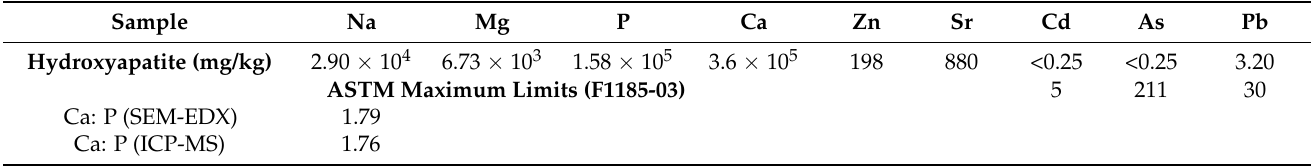
Figure 8. EDX analytical spectra of the CBHA sample. Table 1. Chemical composition of the hydroxyapatite sample obtained via ICP-MS analysis.